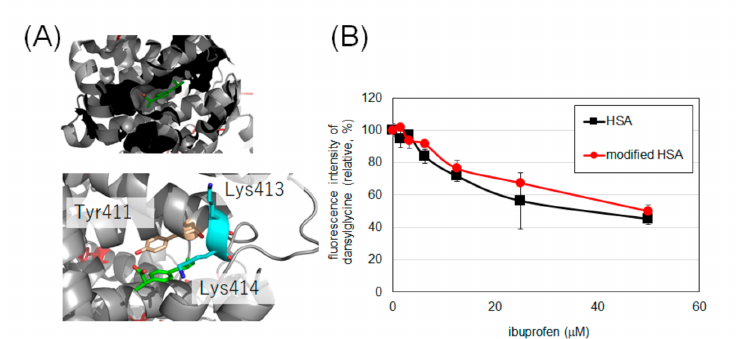
Figure 6. Binding of HSA and modified HSA to ibuprofen. ( A ) The binding of ibuprofen at Sudlow’s site II (PDB: 6U4X). ( B ) Fluorescence changes due to competition between ibuprofen and dansyl- glycine. Error bars, mean ± SD from three independent experiments. These experiments were performed at 25 ◦ C (See Figure S16 for